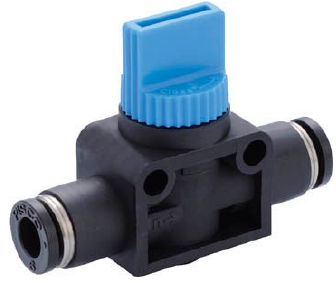
Figure 6. Picture of the hand valve. Table 4. Specifications of the hand valve.